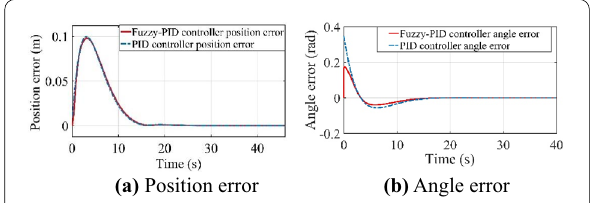
Figure 20 Robot trajectory tracking convergence